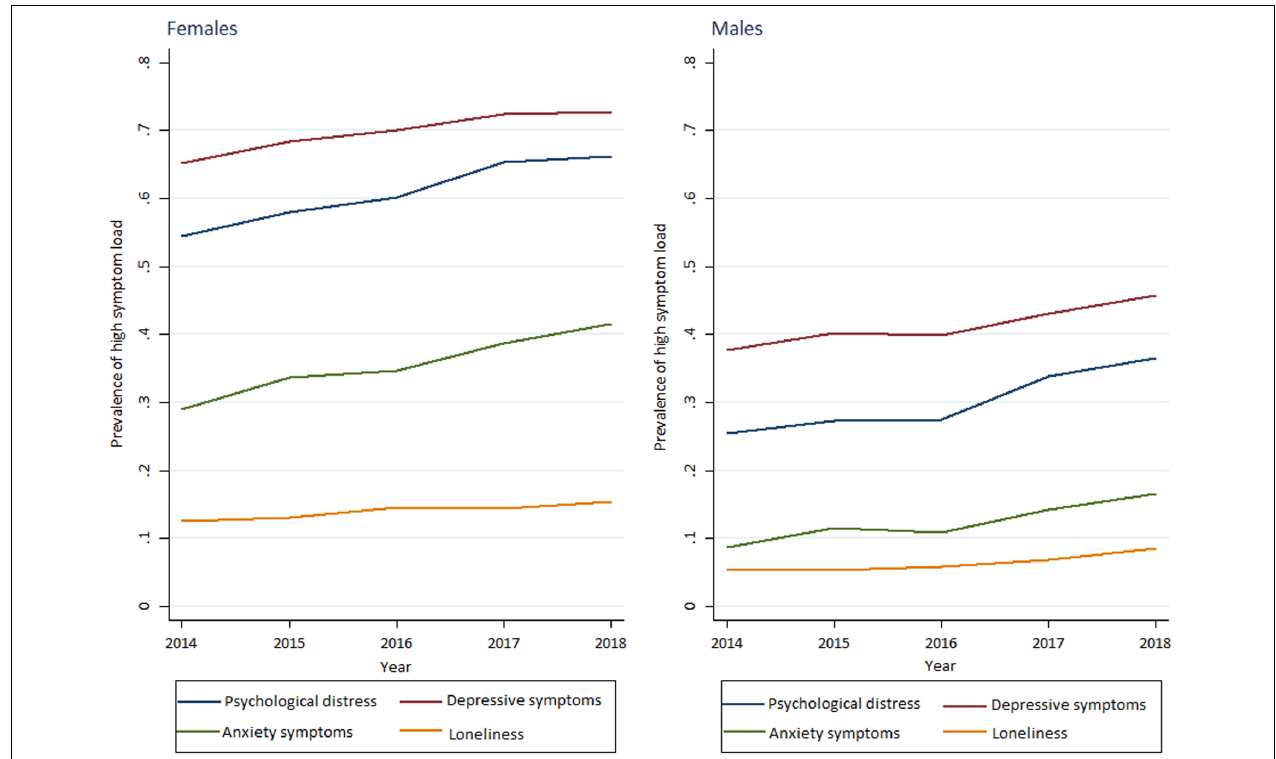
FIGURE 2 | Trends in prevalence of high mental health symptom loads among girls and boys across the five cross-sectional surveys of secondary school students (ungdata survey).